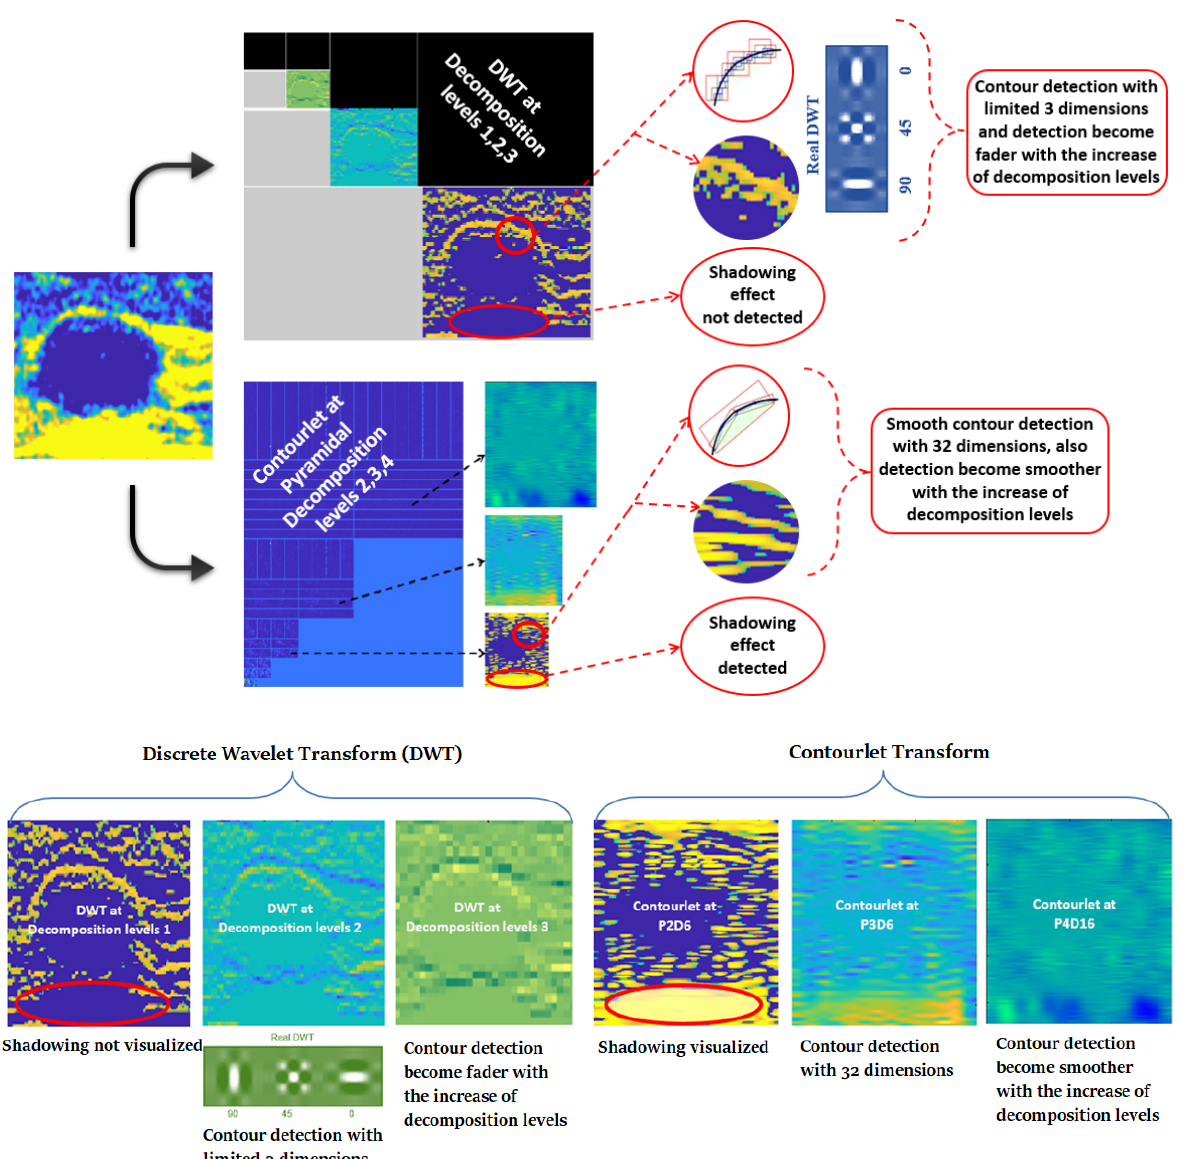
Figure 3. Discrete Wavelet Transform (DWT) versus Contourlet scheme: illustrating the successive refinement of these two different multi-resolution transform domains near a smooth contour.